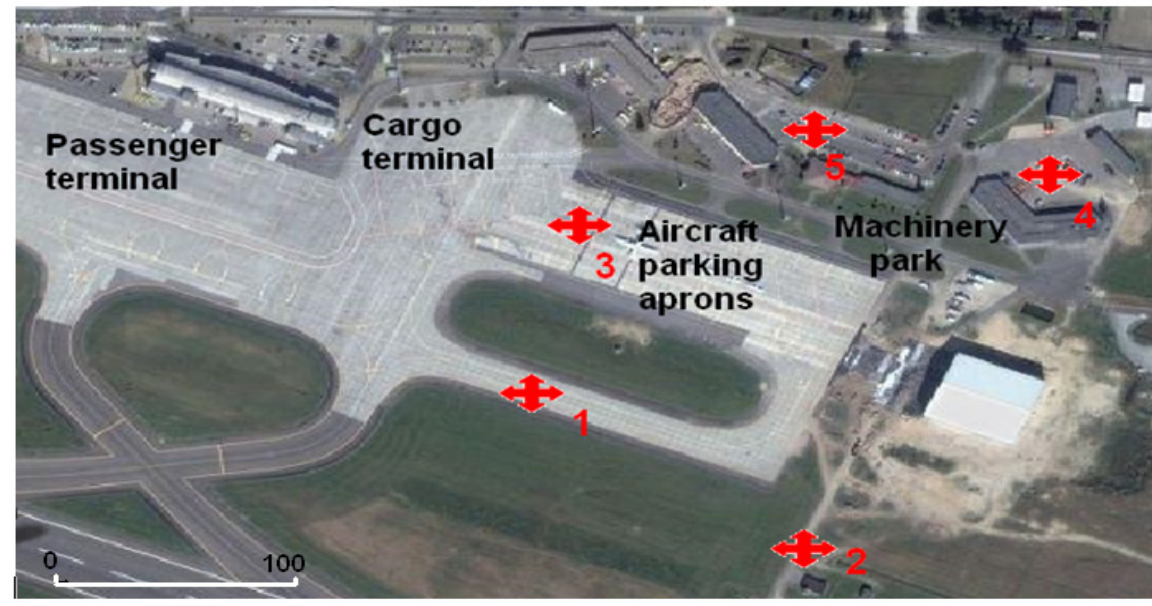
Figure 1. Site description of the Lech Wa ł esa Airport at Gda ń sk R ę